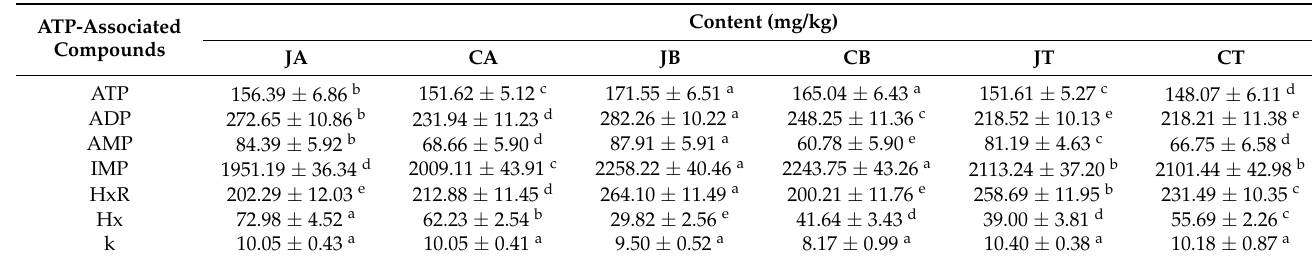
Table 4. Comparison of ATP-associated compounds and K -values in different parts of JPGC and